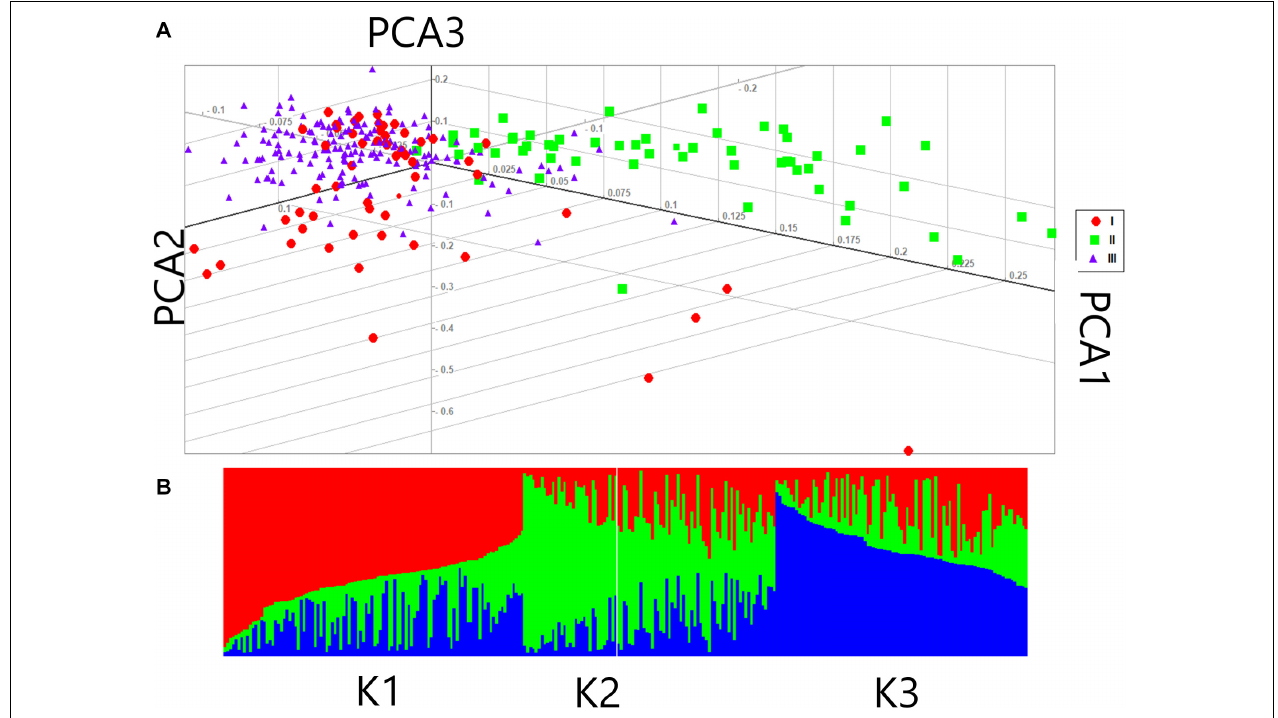
FIGURE 3 | Population structure of 284 female parents in the association panel (A) Principal component analysis (PCA) of female lines (B) Population structure of 284 female parents ( K = 3).